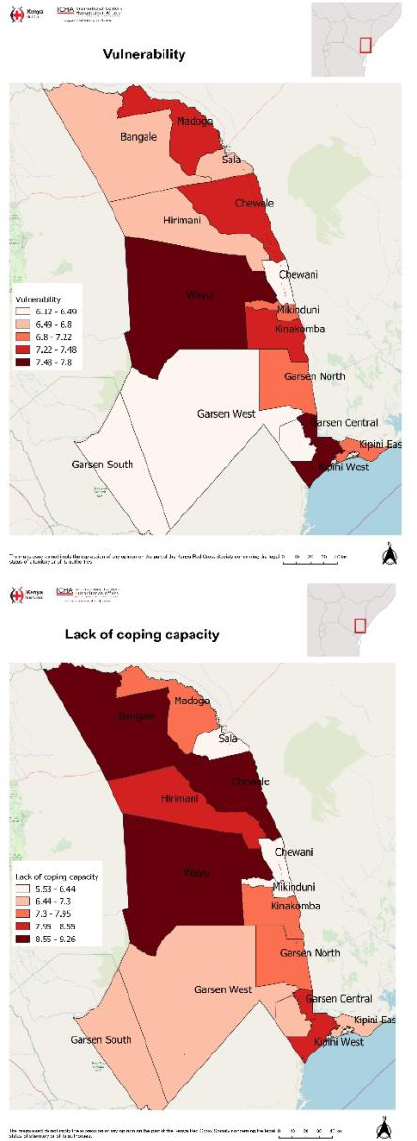
Figure 12 Vulnerability and lack of coping capacity Kipini west and Wayu are the most vulnerable wards. Wayu, Chewele and Bangale wards lack capacity to cope with floods.